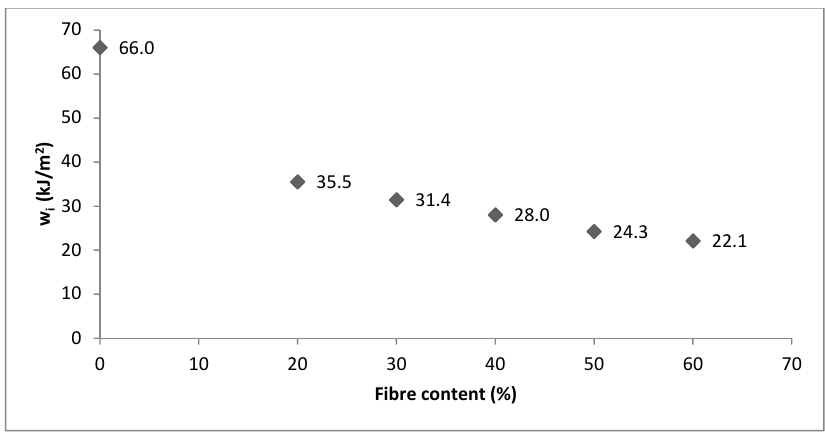
Figure 1. SEM photographs of PA11 + 50%SGW composite at different resolutions.